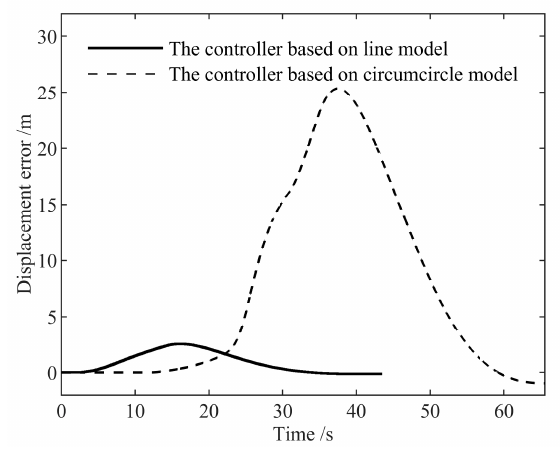
Figure 21. Displacement error between P and the reference path in the second group of simulations.